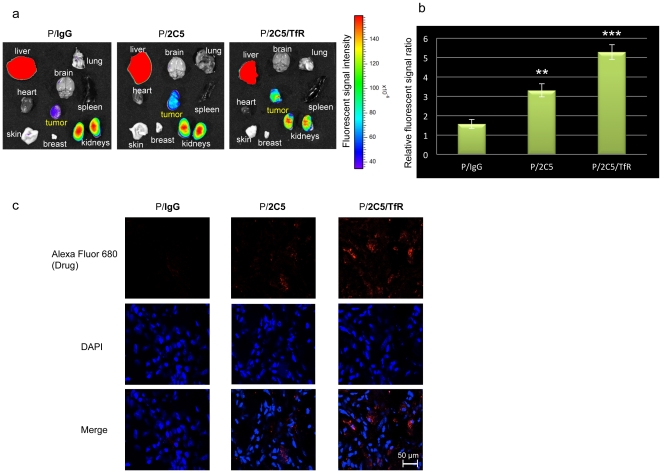
Tumor-specific active targeting effect of the 2C5 antibody in vivo.MDA-MB-468 subcutaneous tumor-bearing mice were injected with Alexa Fluor 680-labeled nanobioconjugates (P/IgG, control; P/2C5 or P/2C5/TfR) through their tail vein. The images were taken 24 hours after the drug injection using Xenogen IVIS 200 system. Although the P/IgG barely accumulated in the tumor by EPR effect, the P/2C5 accumulated in the tumor area significantly more than control (Fig. 4a and 4b, **p = 0.001). The highest drug accumulation was seen in P/2C5/TfR treated group where two different tumor targeting antibodies were combined (Fig. 4a and 4b: p = 0.002 vs P/2C5; ***p = 0.0001 vs P/IgG). Confocal microscopy confirmed drug delivery efficiency of the nanopolymer with dual targeting antibodies, P/2C5/TfR (Fig. 4c).